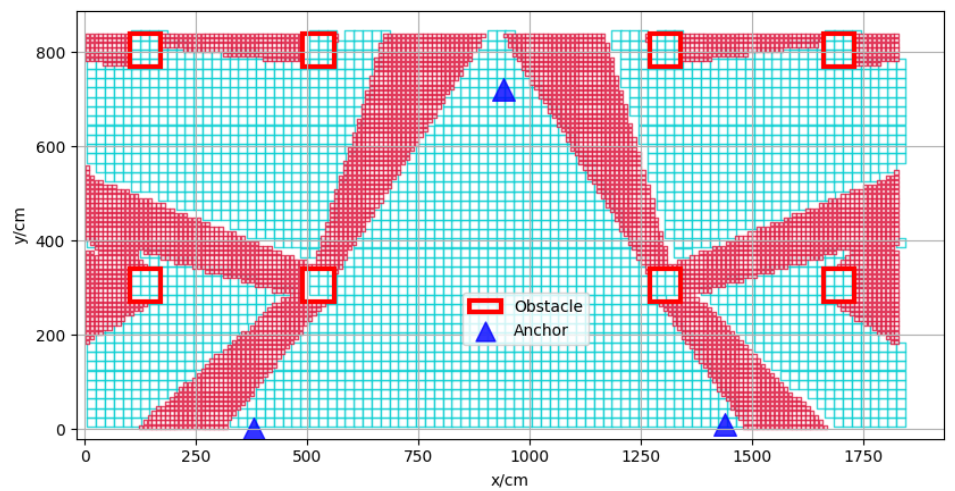
Figure 9. Adaptive measuring point density diagram.